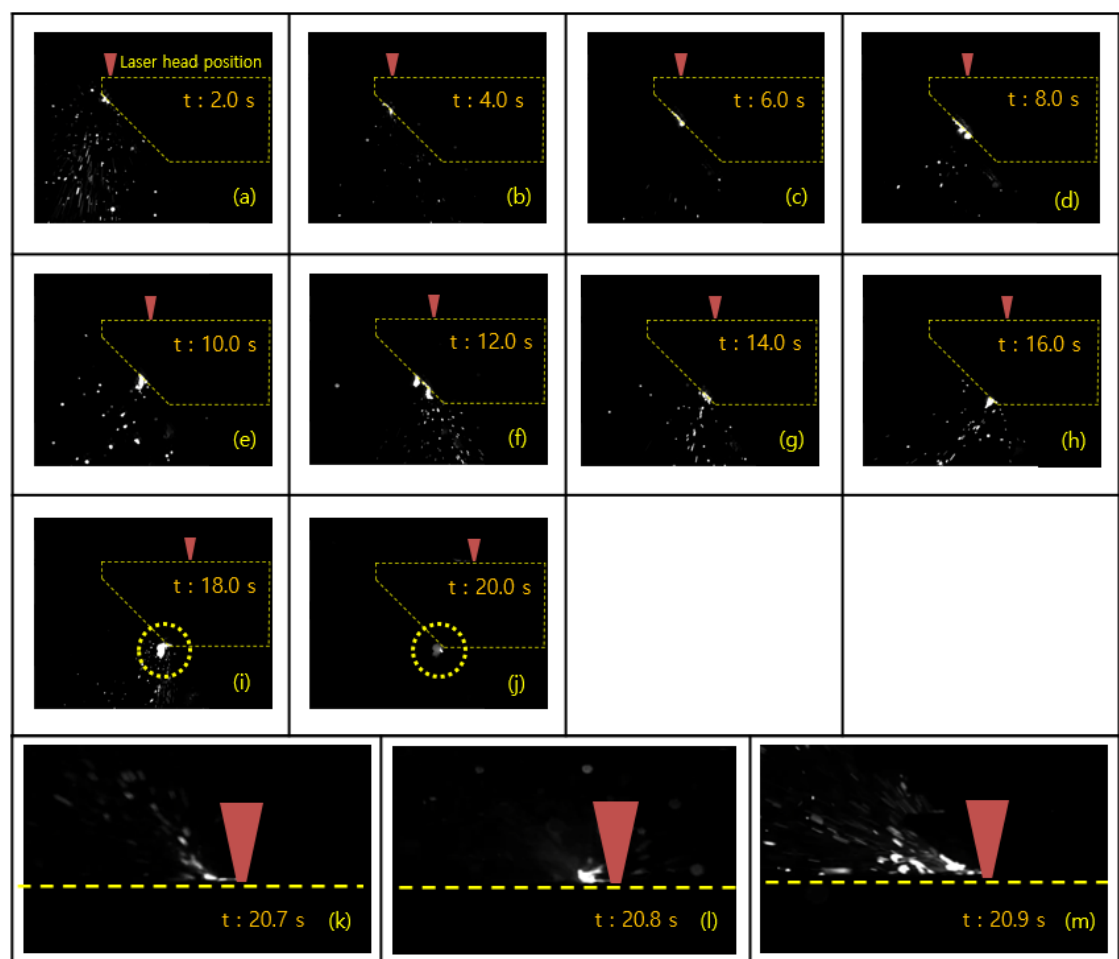
Figure 6. Molten pool behavior and evacuation captured by the high-speed camera in case 2 at ( a ) t: 2.0 s, ( b ) t: 4.0 s, ( c ) t: 6.0 s, ( d ) t: 8.0 s, ( e ) t: 10.0 s, ( f ) t: 12.0 s, ( g ) t: 14.0 s, ( h ) t: 16.0 s, ( i ) t: 18.0 s, ( j ) t: 20.0 s, ( k ) t: 20.7 s, ( l ) t: 20.8 s, and ( m ) t: 20.9 s.